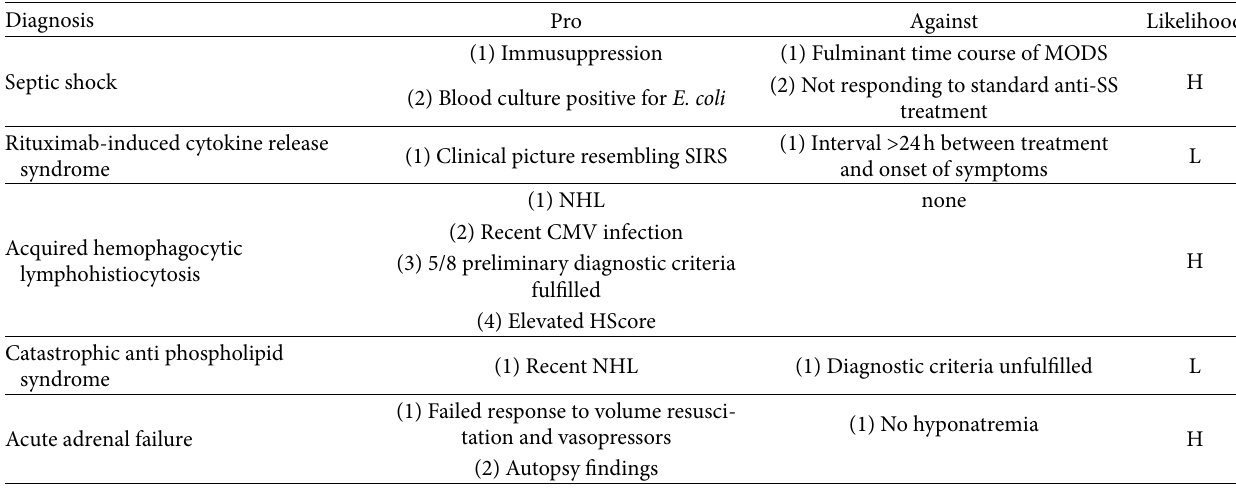
Table 5: Possible differential diagnoses of fulminant MODS.